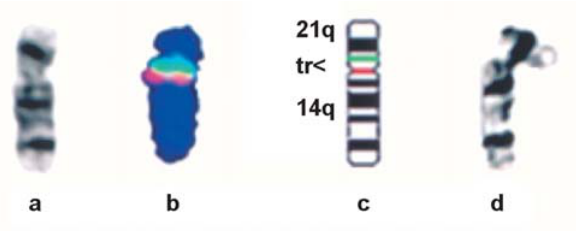
Figure 2 - (a) G-banded chromosome showing rob(14q21q), (b) FISH im- age of a dicentric rob(14q21q) chromosome (green = chr 21 centromere, red = chr 14 centromere), (c) ideogrammatic representation of the dicen- tric rob(14q21q) indicating the 14/21 translocation region (tr) and, (d) a dicentric rob(14q21q) chromosome (from an APC-treated metaphase) with a break at or near Table II - Observed chromosomal gaps/breaks at sites determined to be